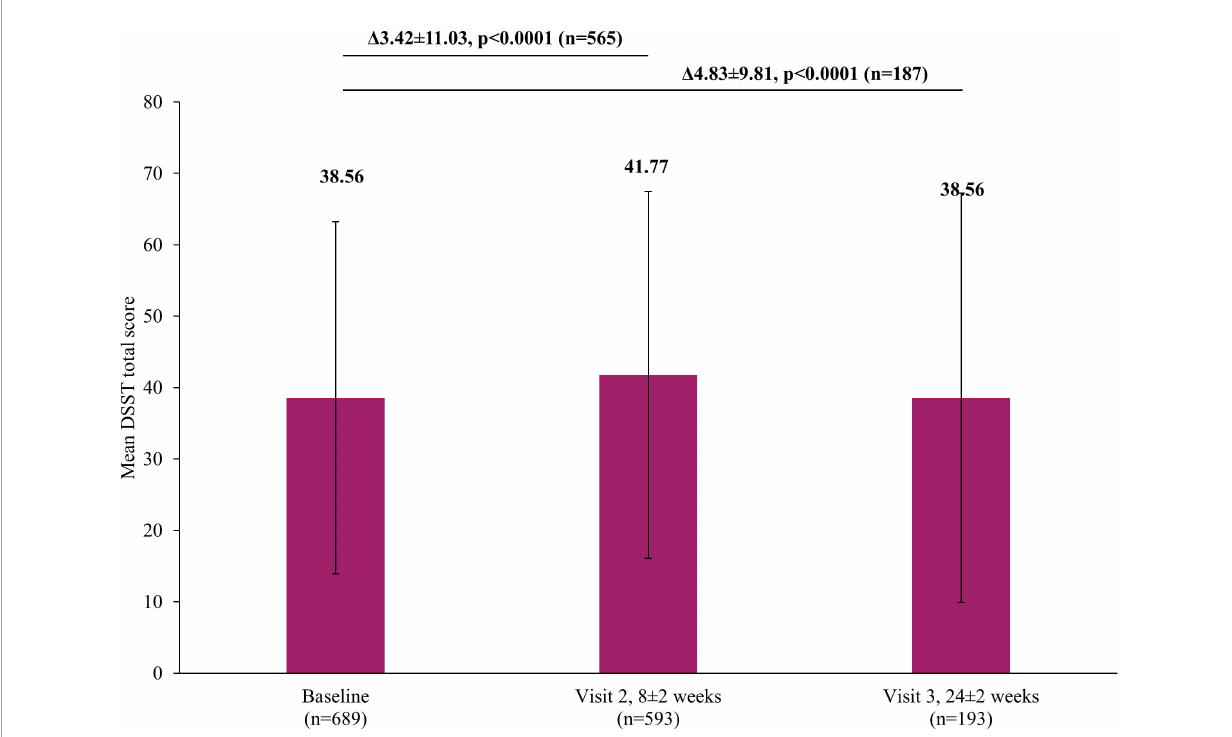
FIGURE6 Change in DSST total score from baseline. The mean DSST total score at Visit 1 was based on all patients, not just those that also had data at Visit 2 or Visit 3, however, when analyzing the difference between the visits (Visit 1 to Visit 2 and Visit 1 to Visit 3), scores of patients who had scores at both visits were included. Therefore paired t -test assessed the difference at Visit 2 (8 ± 2 week) versus Visit 1 (0 week) in 565 patients or difference at Visit 3 (24 ± 2 week) versus Visit 1 (0 week) in 187 patients. Error bars represent standard deviations. DSST, Digit Symbol Substitution Test.